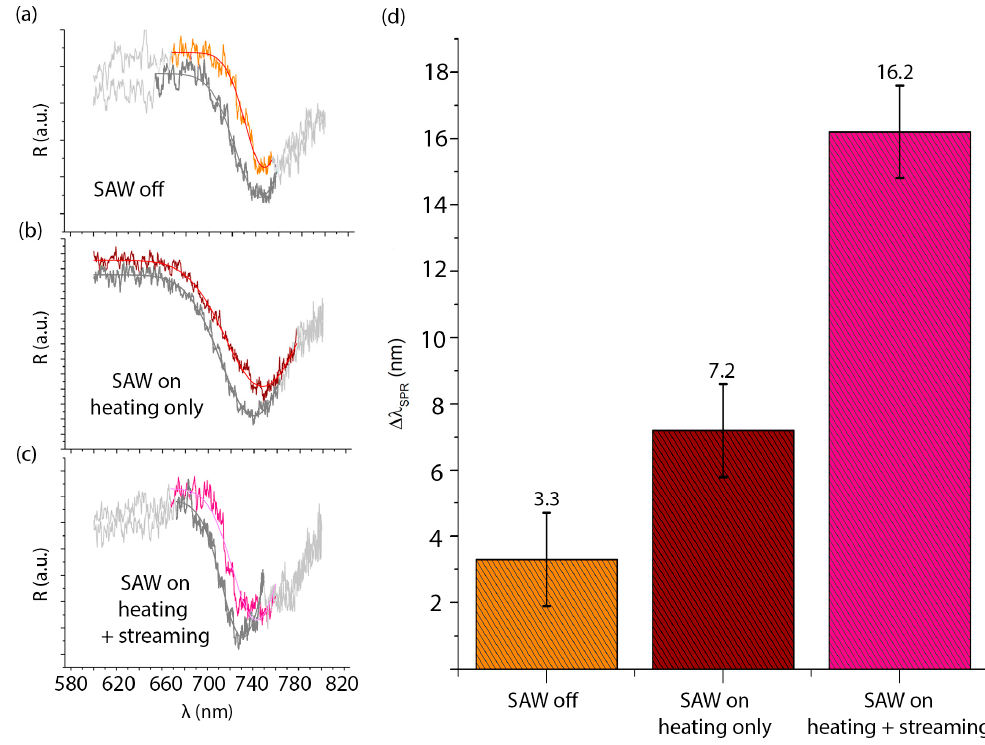
Figure 7. Representative SPR spectra in the case of water-ethanol (10:1 v / v ; dark grey curves), and b-SH in water-ethanol (1 mg/mL) in the microchannel when SAWs are off (orange curve in ( a ), in the microchamber B.2; bordeaux curve in ( b ) where only the heating effect of the SAW is present; and magenta curve in ( c ) where both heating and streaming induced by the SAWs are present. ( d ) Average resonance wavelength shift in the case of b-SH in water-ethanol (1 mg/mL) to water-ethanol only without the SAW, with the heating effect only of the SAW and with the SAW, respectively.